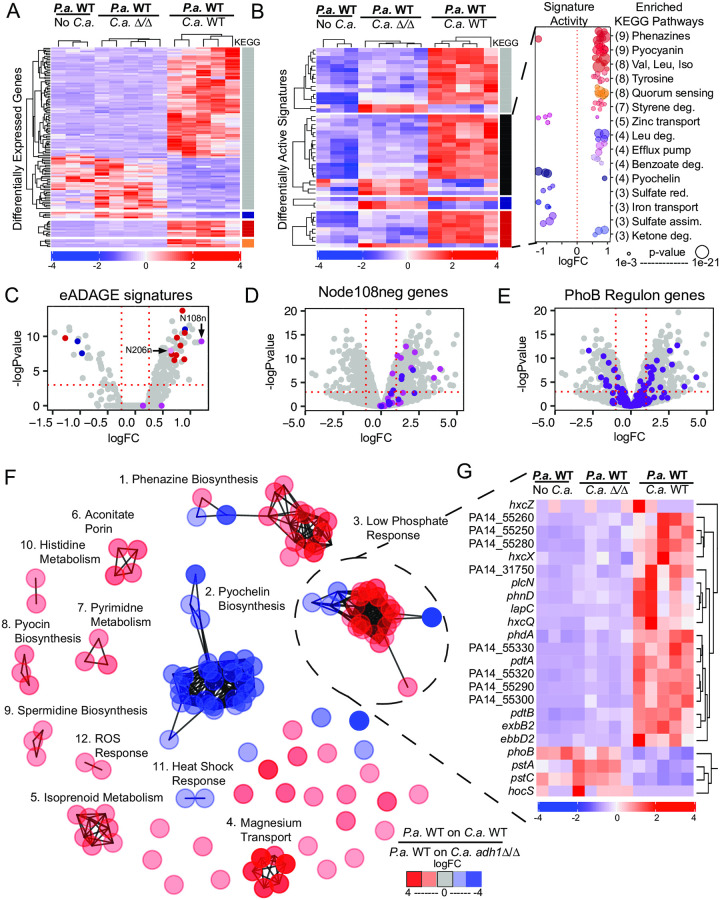
eADAGE analysis reveals a subset of the Pho regulon upregulated in P. aeruginosa (P.a.) grown on C. albicans (C.a.) WT compared to that on C.a. adh1Δ/Δ.A) Differentially expressed genes (DEGs) between P.a. grown alone or on C.a. WT and C.a. adh1Δ/Δ for 24 h. annotated with KEGG pathways (quorum sensing, orange bar; phenazine biosynthesis, red bar; and pyochelin biosynthesis, blue bar; other or none, grey). B) Differentially active eADAGE signatures (DASs) for the same samples shown in A. Signatures with over-represented KEGG pathways annotated (phenazine biosynthesis, red bar; and pyochelin biosynthesis, blue bar; other, black; or none, grey). Inset shows the fold-change for the expression all of the KEGG pathways that are over-represented among the DASs (# of DASs per KEGG pathway in parentheses); over-representation p-value shown as circle size (S2 Dataset). C) DASs with increased activity in transcriptome comparisons of P.a. grown on C.a. WT versus adh1Δ/Δ. Over-represented KEGG pathways and pathways of interest are colored (phenazine biosynthesis, red dots; pyochelin biosynthesis, blue dots; ethanol catabolism, N206n pink dot; the PhoB regulon, N108n violet dot). D) P.a. gene expression between co-culture with C.a. WT and adh1Δ/Δ, genes in N108n colored violet and genes also in the PhoB regulon in purple with DEGs cutoffs logFC > 1, FDR < 0.05 marked with red dotted lines. E) Same P.a. genes expression as D, genes in the PhoB regulon colored purple. F) Network analysis of DEGs suggest groups of DEGs have correlated patterns across eADAGE: phenazine biosynthesis (1) is inversely expressed with the low iron response (2) and coordinately upregulated with the low-phosphate response (3) upon exposure to ethanol in co-culture. Other cliques of DEGs participate in shared biological pathways. Descriptions of all cliques in S1 Table. G) The Pho Clique (3) contains two clades of DEGs with opposing expression patterns between P.a. grown on C.a. WT and C.a. adh1Δ/Δ.